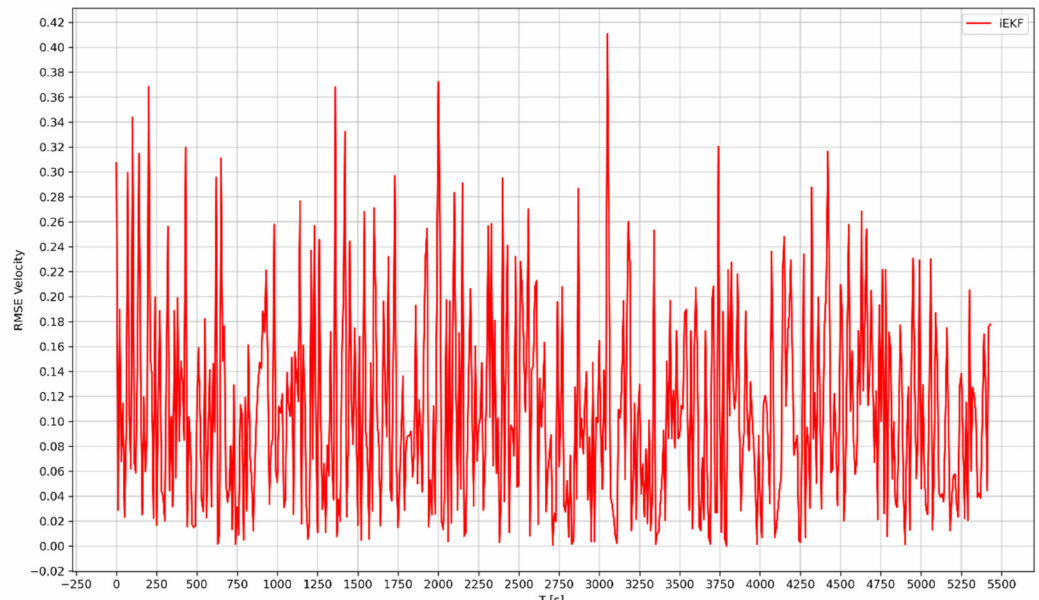
Figure 10. Case 1: iEKF RMSE for the